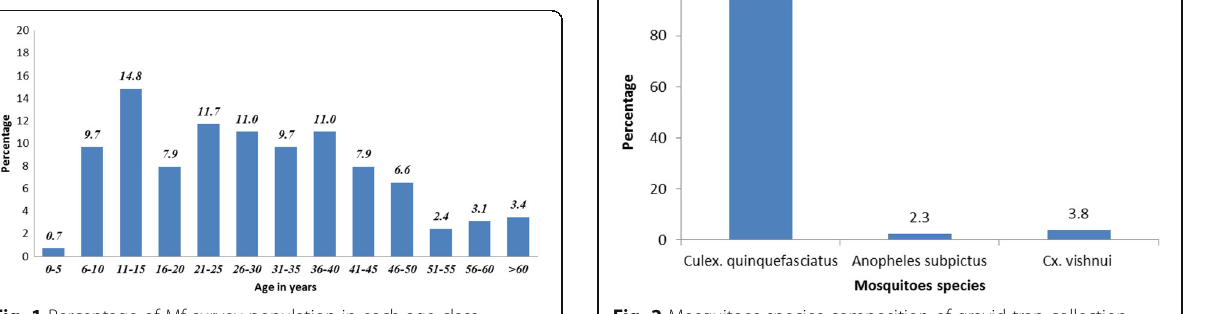
Fig. 2 Mosquitoes species composition of gravid trap